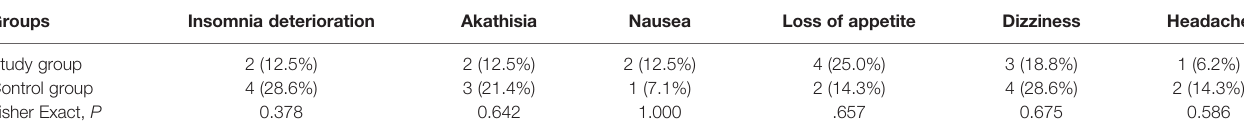
TABLE 6 | Comparison of side effects between the two groups.